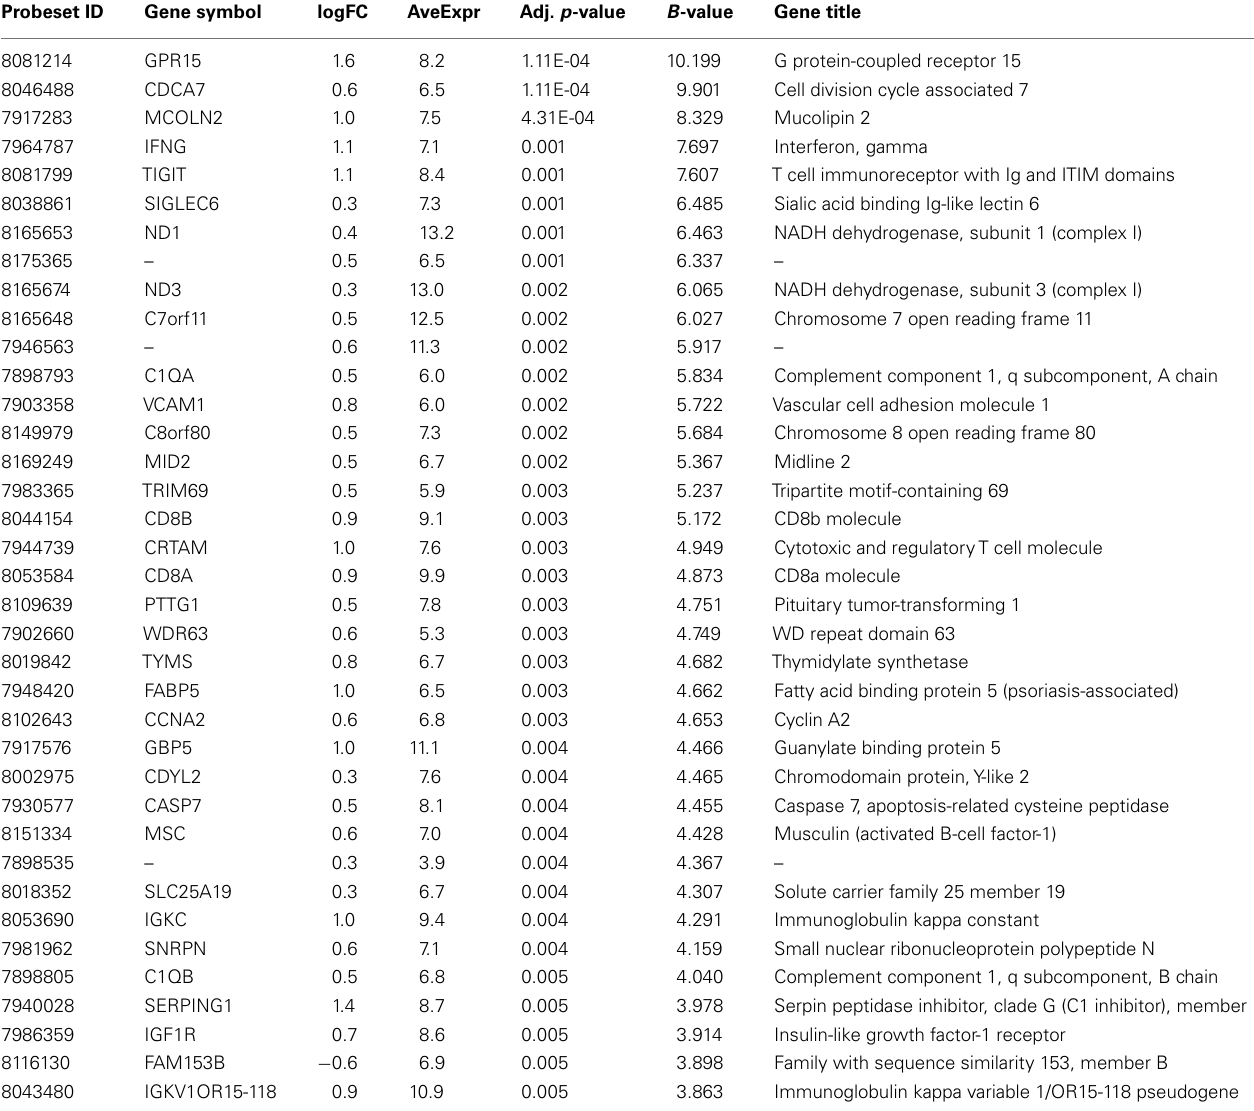
Table 2 | Differential expression analysis of the blood RNA suggests significant differences between study groups. Probeset